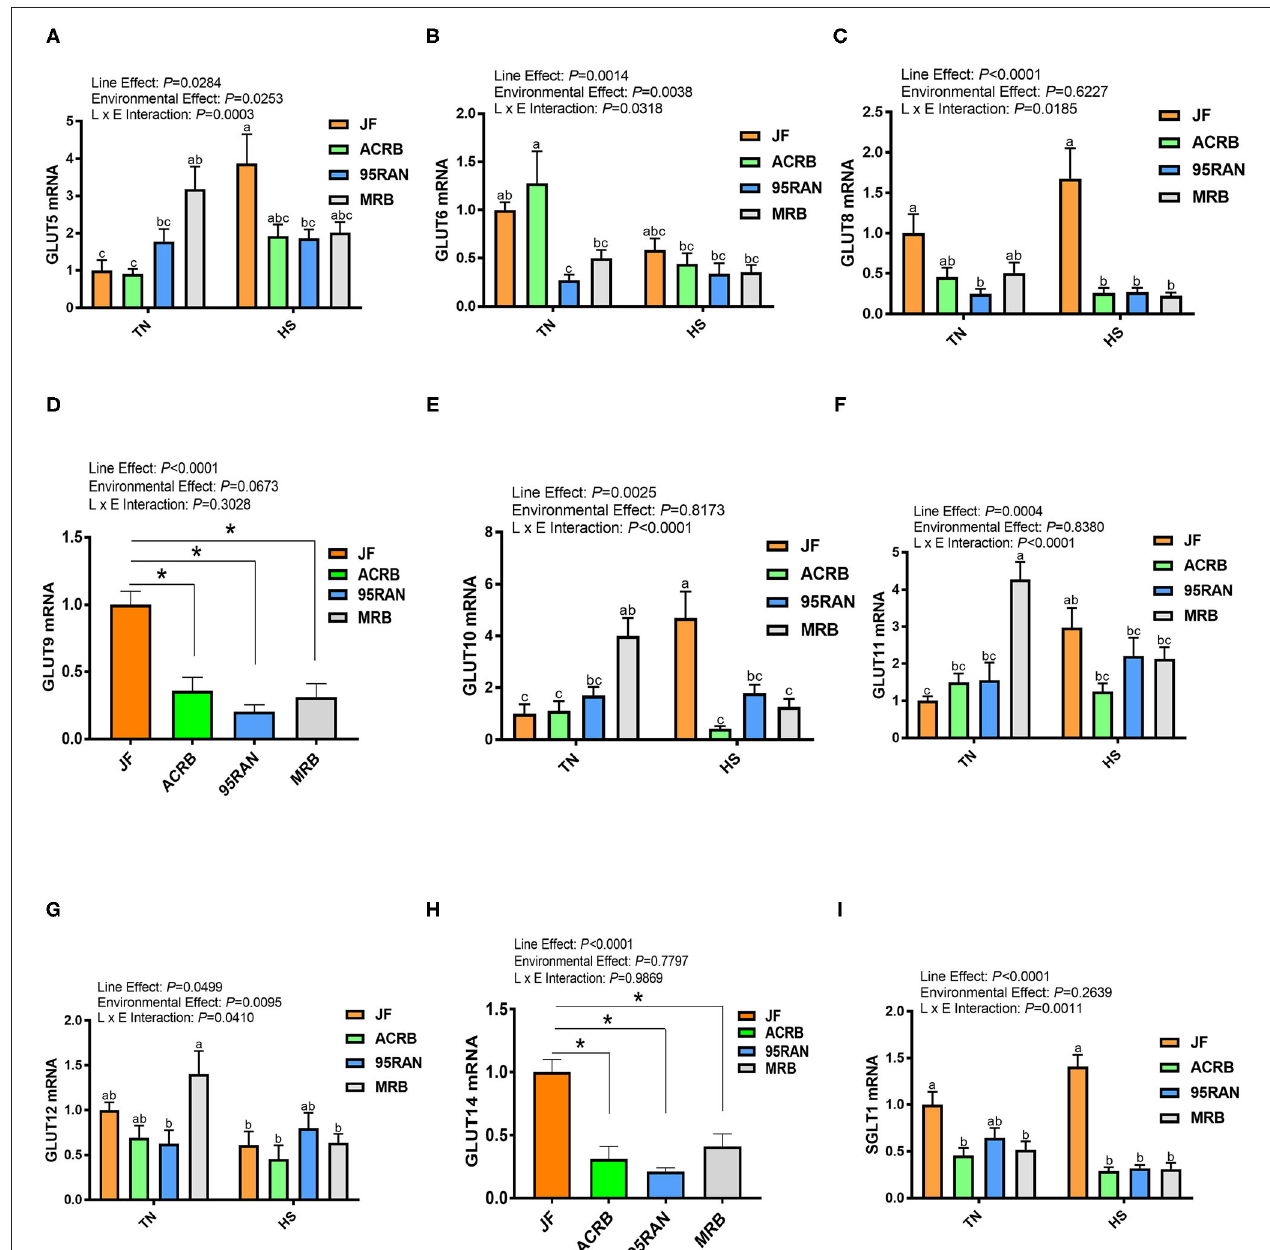
FIGURE 4 | Effect of HS on the carbohydrate transporter gene expression in the jejunum of JF, ACRB, 95RAN, and MRB birds. (A–I) RNA was extracted from tissue and analyzed by qPCR. Gene expression data are mean ± SEM ( n = 6/group). Different letters indicate the significant difference at P < 0.05 when the interaction is significant. *indicates a significance compared to JF at P < 0.05. GLUT, glucose transporter; HS, heat stress; SGLT1: Sodium/glucose cotransporter 1; TN, thermoneutral; JF, jungle fowl; ACRB, Athens Canadian Random Bred; 95RAN, 1995 random bred; MRB, modern random